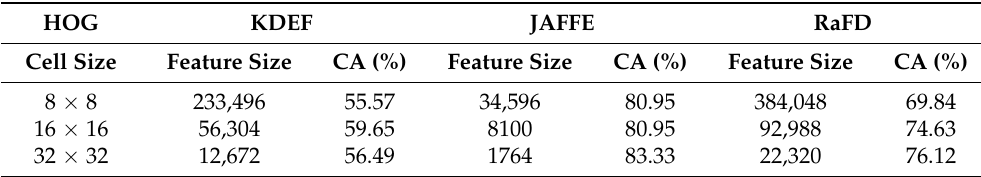
Table 3. Classification accuracy and feature size with HOG method applied to the original image dimensions.